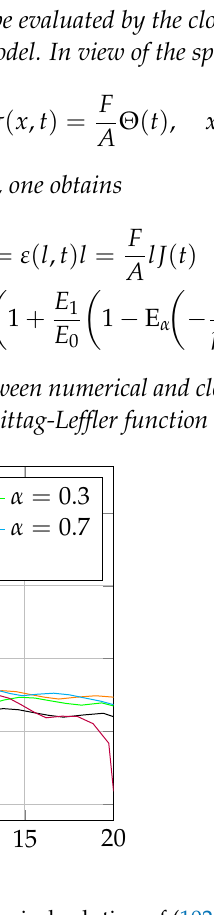
Figure 8. Relative error of the numerical solution of (102a)–(102d) using